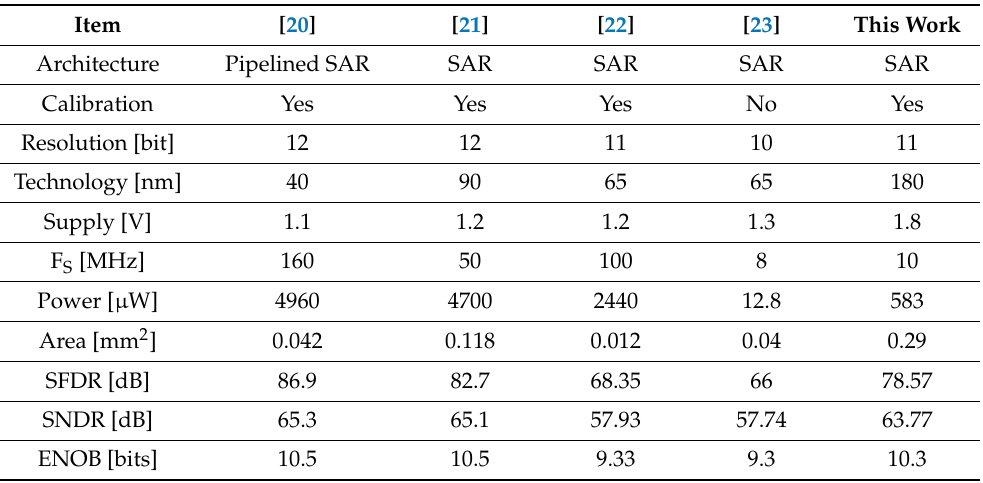
Table 2. Performance comparison of SAR